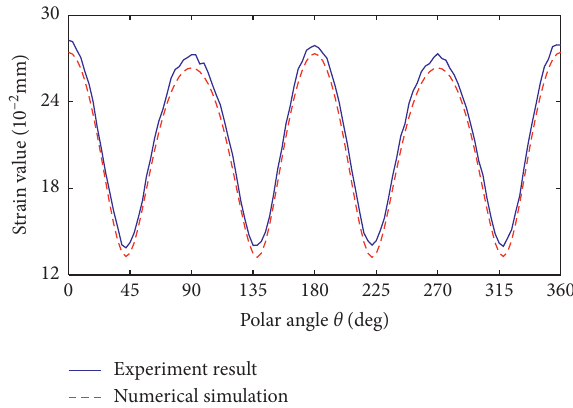
Figure 10: Deformation of the flexspline from the experiment and from the numerical